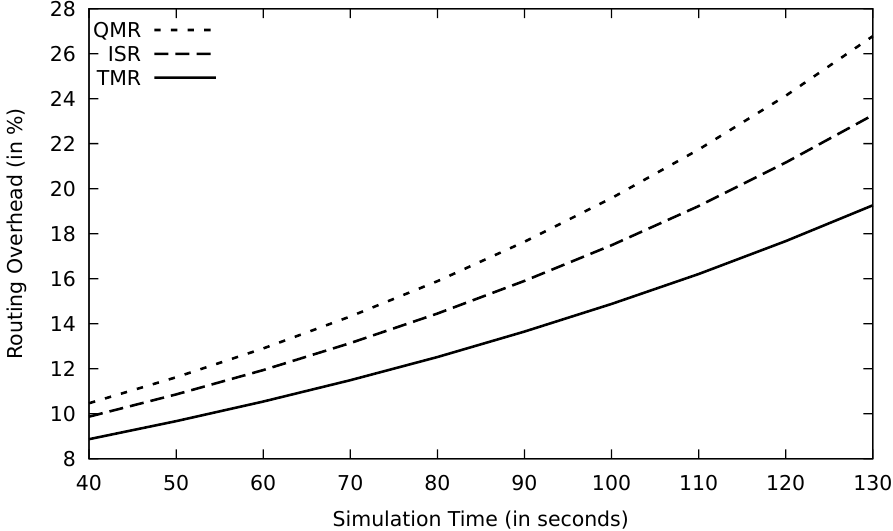
Figure 27. Comparison of EGSR, ISR, and proposed protocol TMR for routing overhead with simulation